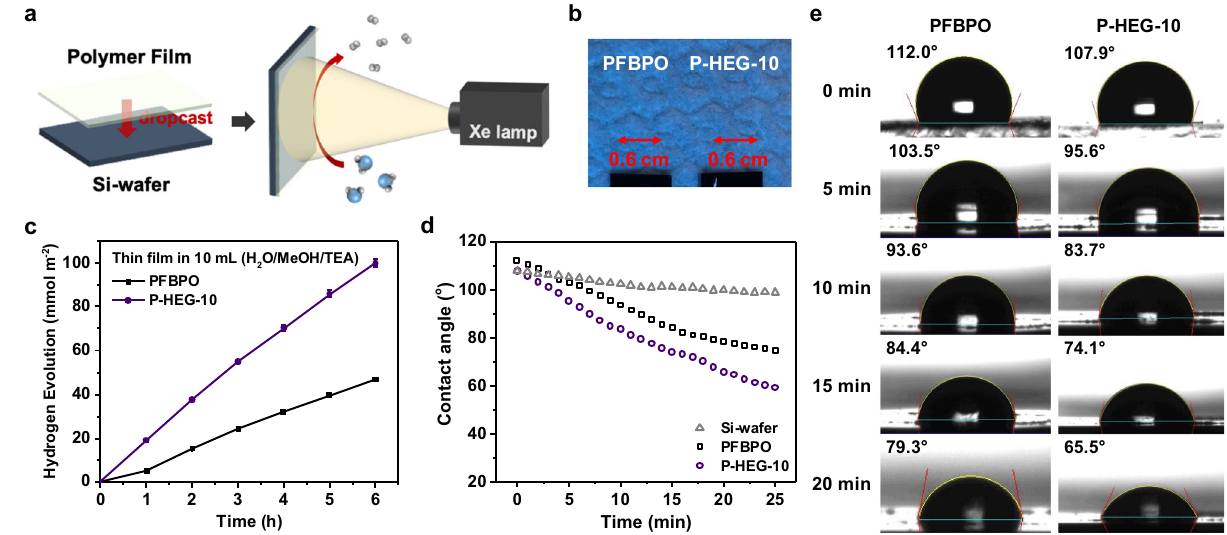
Fig. 5 | Photocatalytic hydrogen evolution experiments in fi lm. a Schematic illustration of the photocatalytic hydrogen evolution in fi lm systems. b Images of the 0.6×0.6cm 2 fi lm over PFBPO and P-HEG-10. c Time-dependent HER of PFBPO and P-HEG-10 fi lm immersed in 10mL of a H 2 O/MeOH/TEA solution under